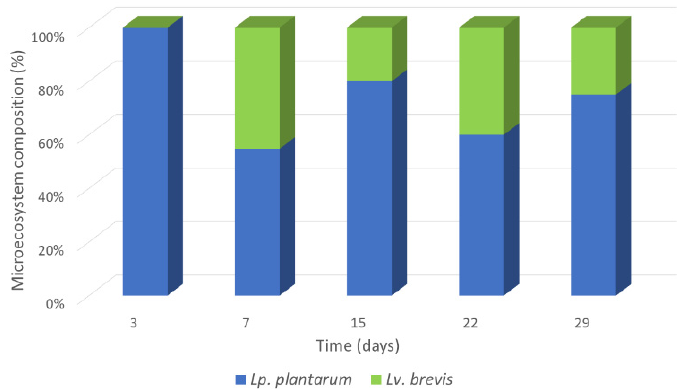
Figure 1. Population dynamics during spontaneous avyrtake fermentation.